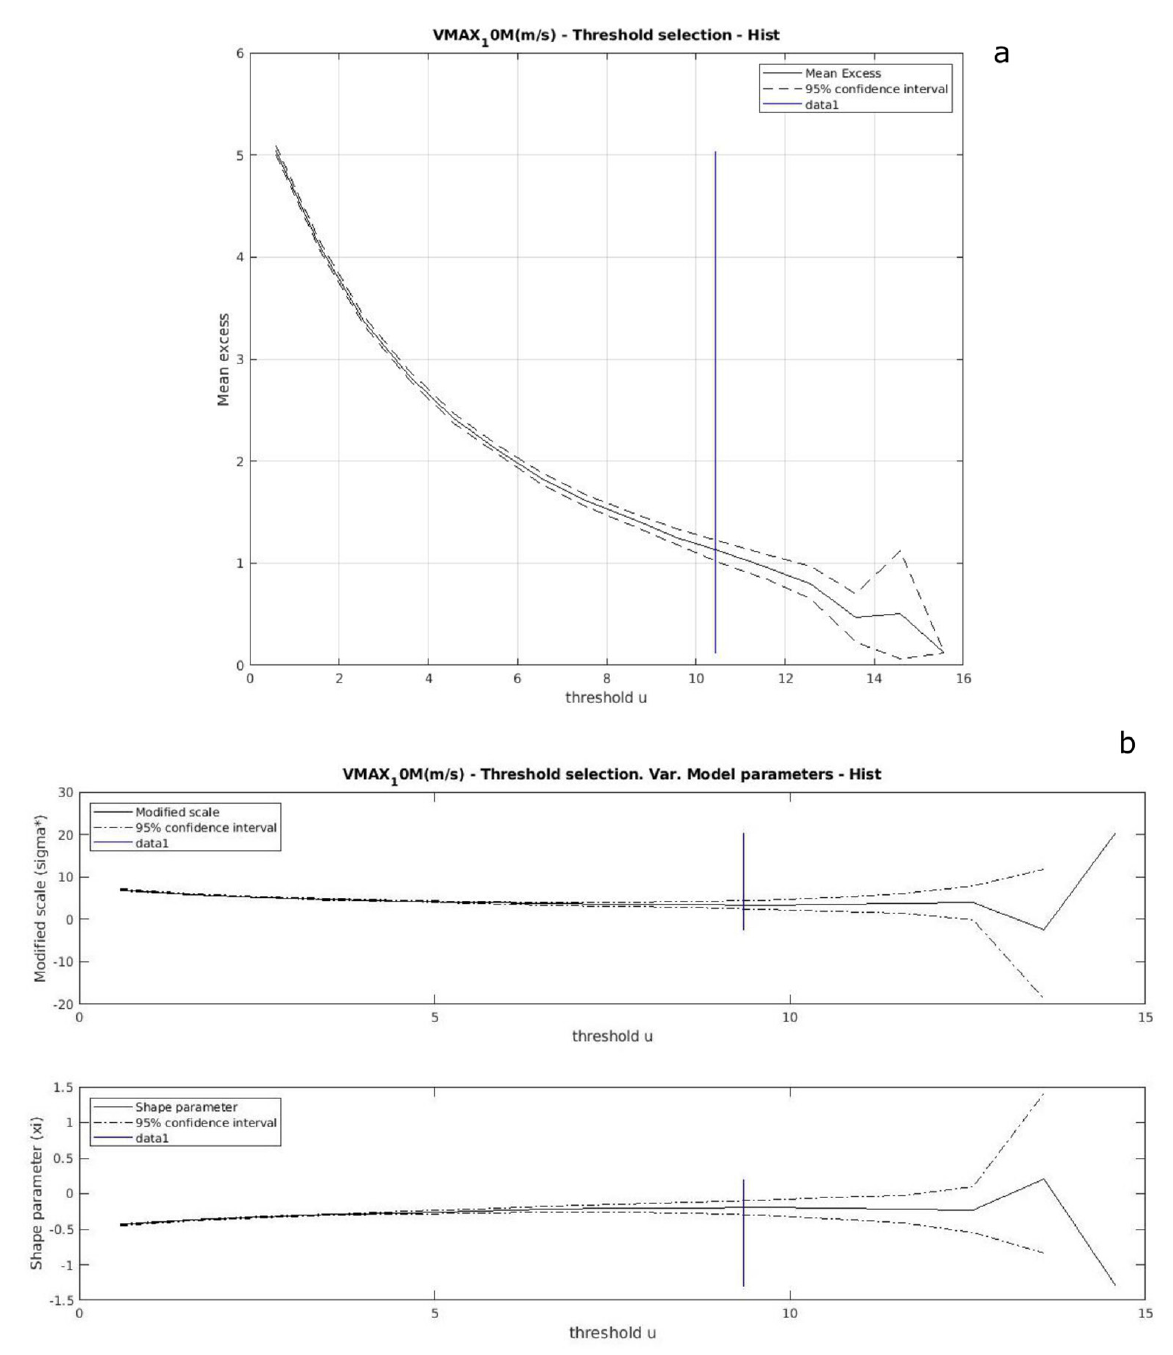
Figure A1. Graphs for the identification of the threshold for POT analysis of wind data for the historical period reference (1980–2019). ( a ) Graph of the “mean residual life” as a function of the threshold u . ( b ) Graphs of model parameters ( σ * e ξ , respectively) for evaluating their stability with the variation of the threshold u .